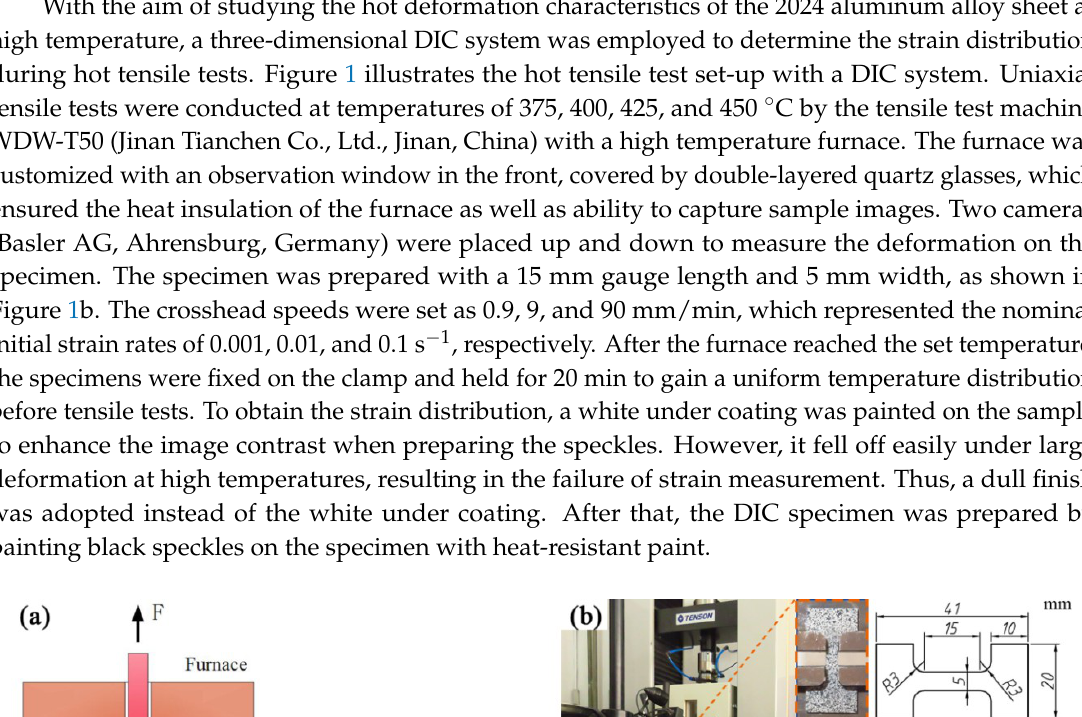
Figure 1. Hot tensile test with digital image correlation (DIC): ( a ) schematic diagram; ( b ) setup.